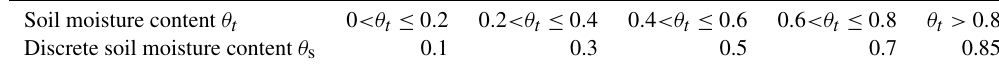
Table 5. The soil moisture content θ t of each period corresponds to the discrete soil moisture content θ s . Soil moisture content θ